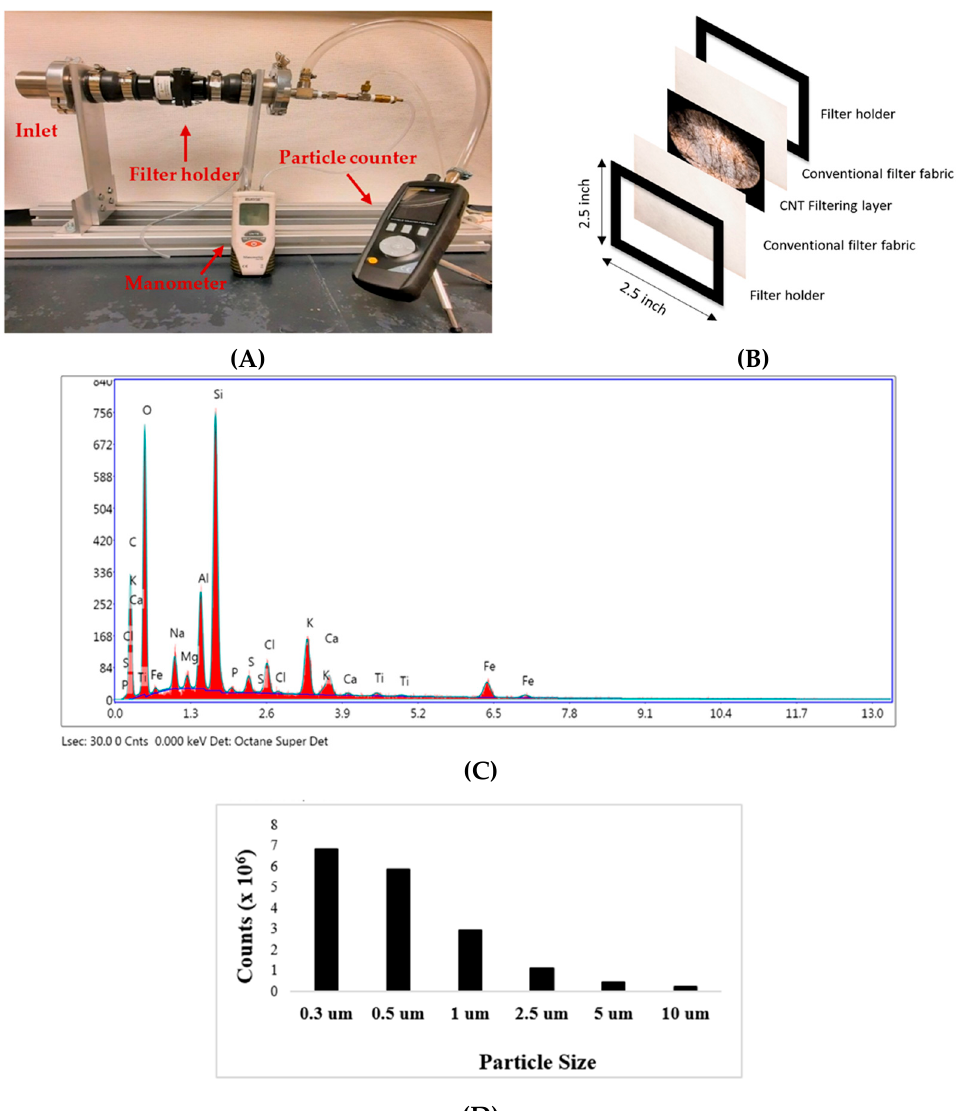
Figure 1. ( A ) The experimental setup, ( B ) a schematic diagram of CNT composite filter structure, ( C ) EDX spectrum of PM, and ( D ) PM